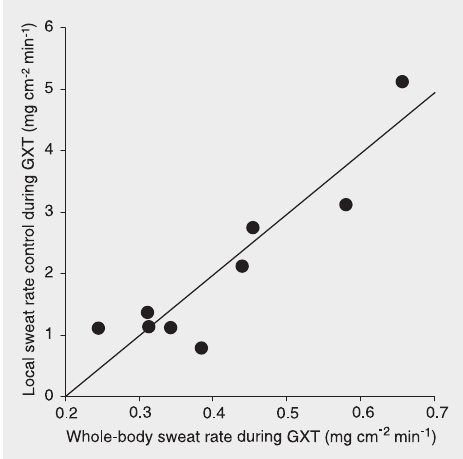
Figure 2. Correlation between whole-body sweat rate and local sweat rate on the left forearm (control) during the graded exercise test until exhaustion (GXT). The Pearson correlation test was used to obtain r = 0.92 and P =